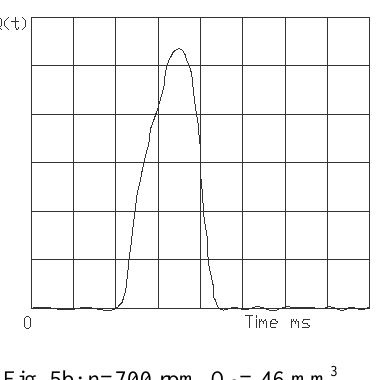
Fig. 5a: n=700 rpm, Q 1 = 43 mm 3